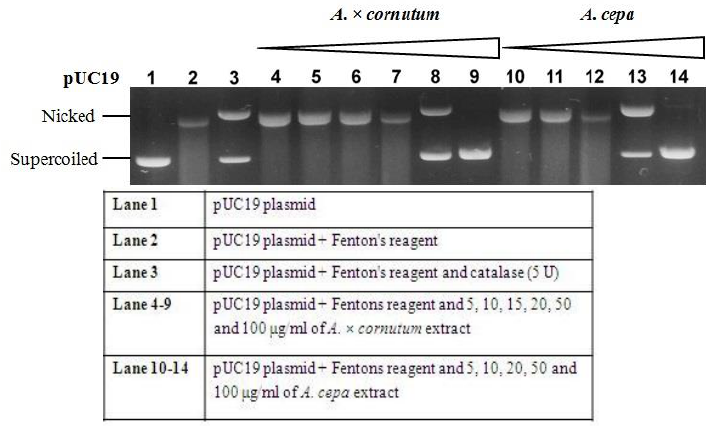
Figure 2. Protective effects of both onion extracts on supercoiled pUC19 DNA.